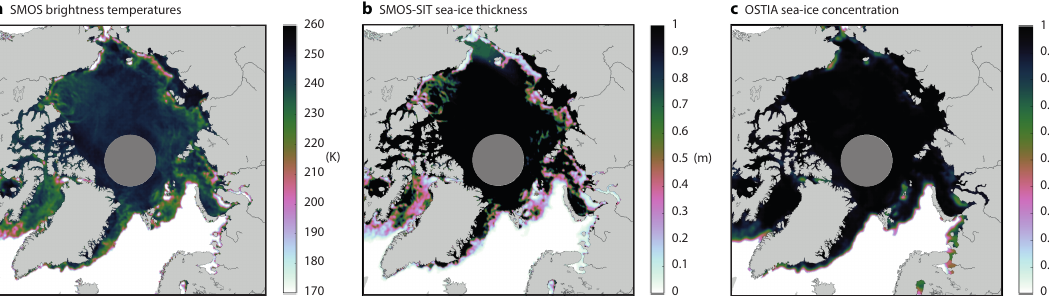
Figure 24. Daily-mean fields for 16 April 2017 showing ( a ) brightness temperature in L-band from SMOS (K); ( b ) sea-ice thickness from the University of Hamburg SMOS sea-ice thickness product (m); and ( c ) observed sea-ice concentration from the EUMETSAT Ocean and Sea–Ice Satellite Application Facility (OSI-SAF). Brightness temperatures over land are masked out. The greyed-out area around the North Pole does not have observations due to the characteristics of orbit and instrumentation of the SMOS